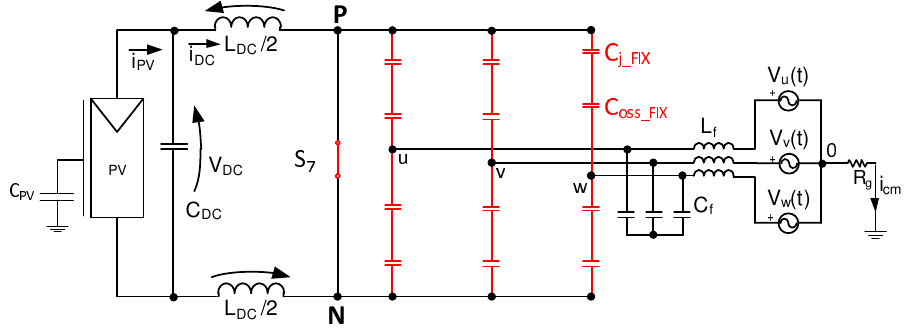
Figure 4. CSI7 topology in the case of Zero Vector applications with power devices parasitic